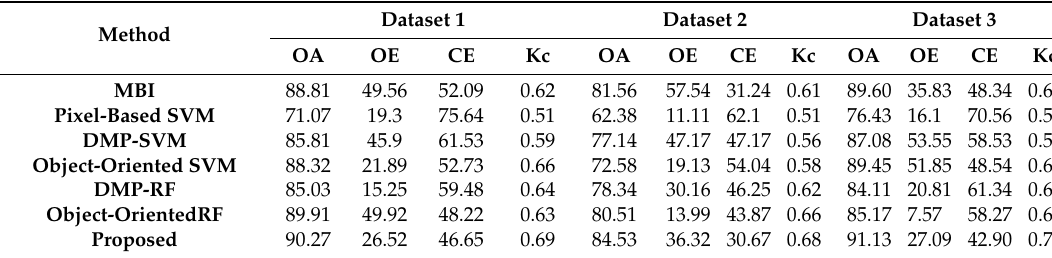
Table 5. Building detection accuracies of the test